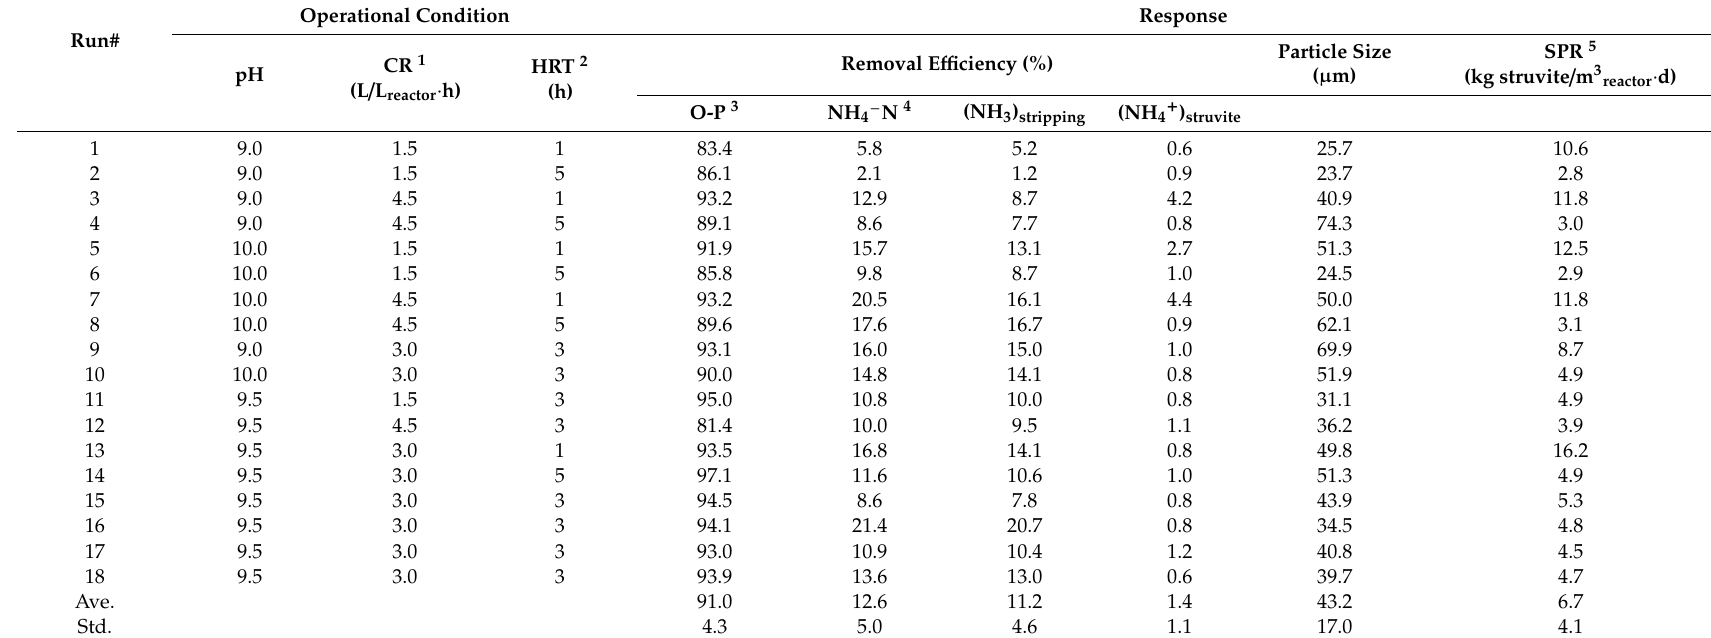
Table 5. Experimental results from 18 runs by